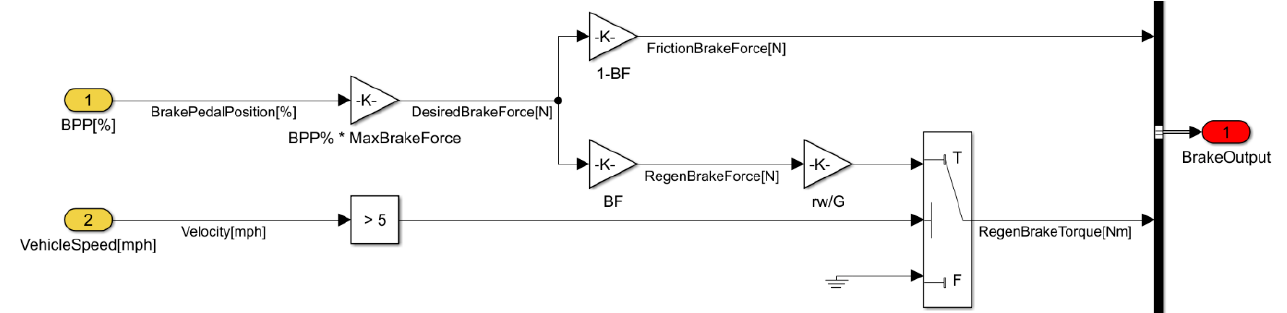
Figure 9. Braking system block Adapted from [16], MathWorks: 2020.